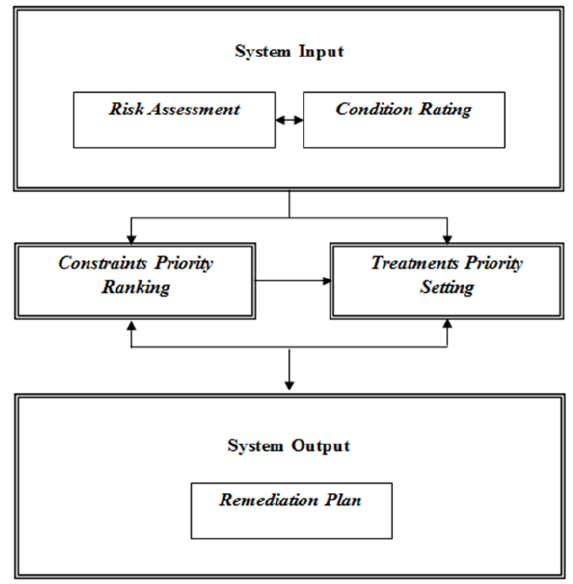
Figure 1. The Proposed Decision Model for Remediation Planning.